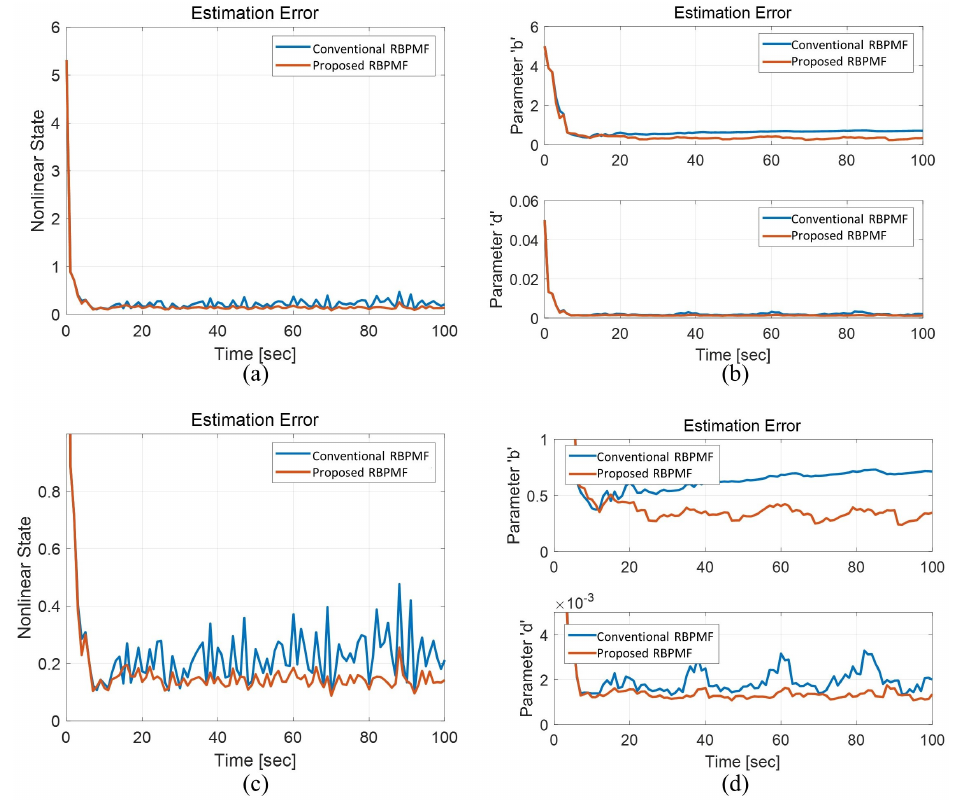
Figure 9. Comparison of the simulation error RMS of the RBPMFs for the growth model with two unknown parameters ( a ) Nonlinear state estimation error ( b ) Parameter estimation errors ( c ) Magnification of ( a ) ( d ) Magnifications of ( b